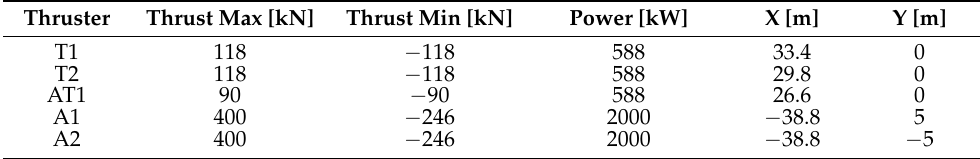
Table 4. Thruster data for conventional positioning system.